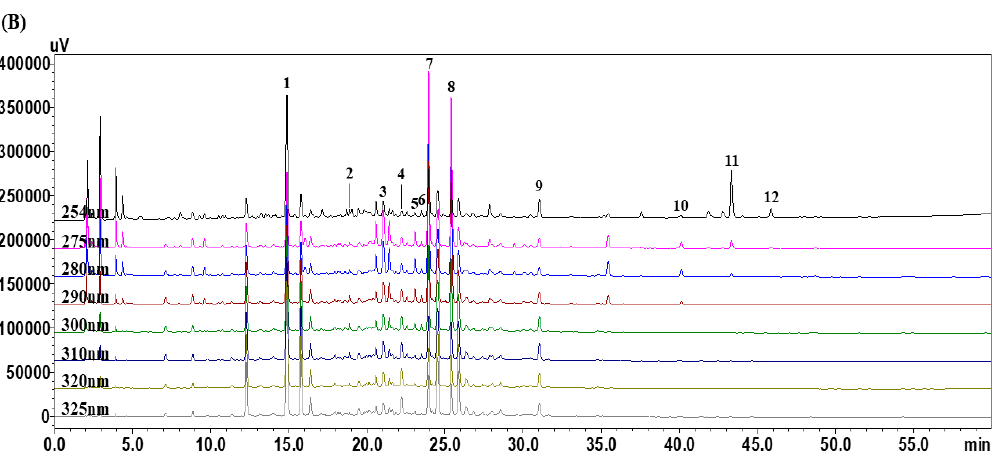
Figure 1. HPLC chromatograms of the standard solutions ( A ) and YPS sample ( B ). 3-CQA ( 1 ), CFG ( 2 ), LIQA ( 3 ), FA ( 4 ), NAR ( 5 ), 5-MVS ( 6 ), NAG ( 7 ), NHES ( 8 ), OPDH ( 9 ), ARC ( 10 ), GA ( 11 ), and 6-GIN ( 12 ).